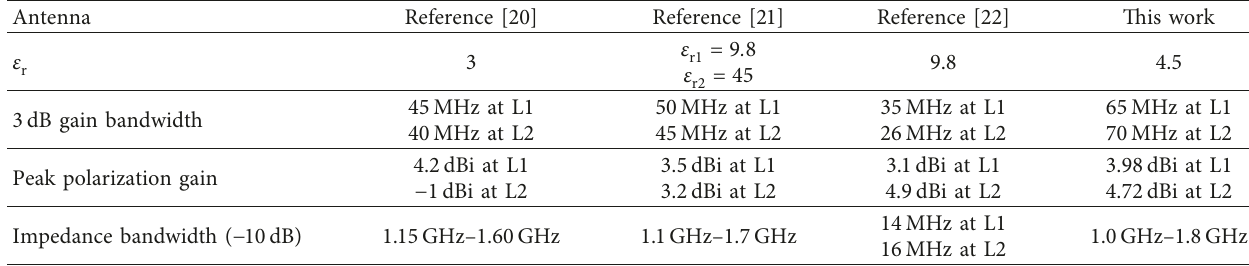
Table 3: Comparisons between our design and previous